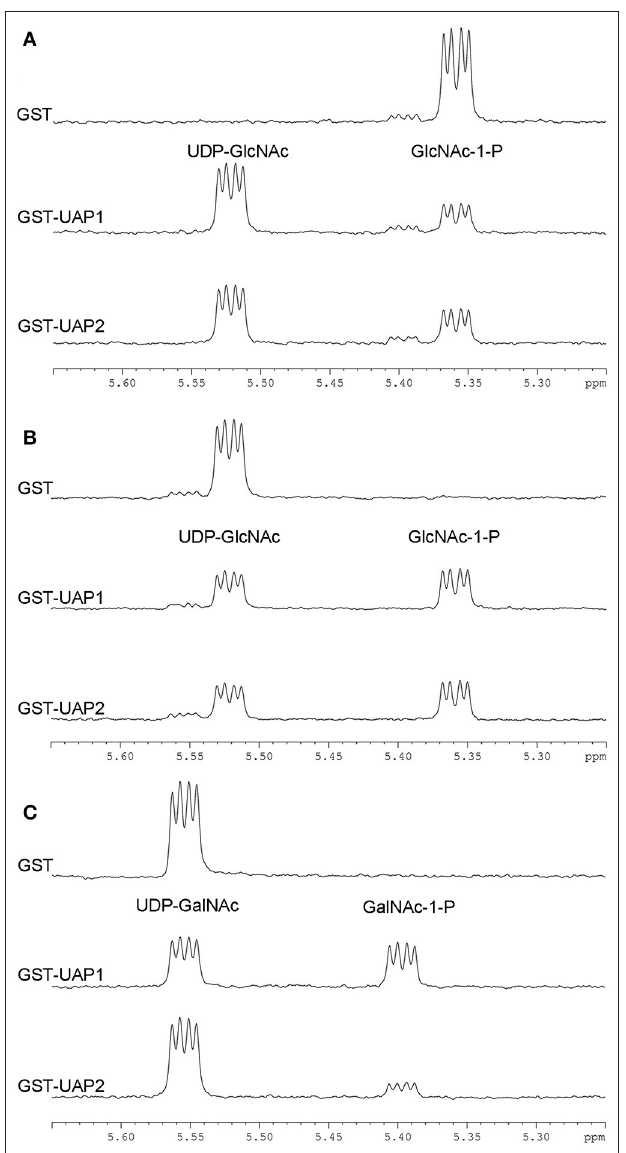
FIGURE 4 | Enzymatic activities of UAP2 and UAP1 proteins based on 1 H-NMR. (A) Forward UAP activity: UTP + GlcNAc-1-P → UDP-GlcNAc + PPi. The chemical shift (indicated by the “peak” shape) of 5.36 p.p.m is for the substrate GlcNAc-1-P and 5.52 p.p.m for the product UDP-GlcNAc. (B) Reverse UAP activity: UDP-GlcNAc + PPi → GlcNAc-1-P + UTP. The chemical shift of 5.52 p.p.m is for the substrate UDP-GlcNAc and 5.36 p.p.m